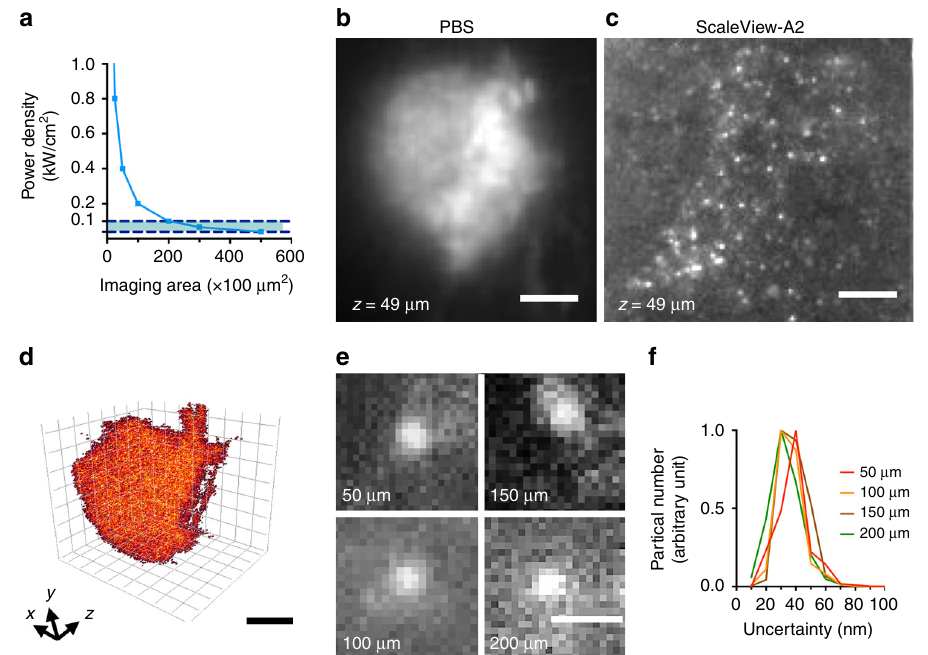
Fig. 2 HMSiR blinking signal at different depths with tissue clearing. a The power density can be achieved by our system is plotted with respect to the imaging area that can be covered by lightsheet. The estimation is made by assuming all the power measuring at the back aperture of the excitation objective (20 mW) is transduced into the lightsheet and the imaging area is product of the axial length and the scanning range of the Bessel beam. The maximum axicon lightsheet coverage is 20,000 μ m 2 (at the power density of 0.1 kW/cm 2 ). Recommended power density ranges for HMSiR activation are indicated in blue. b Representative images of HMSiR blinking signal in phosphate-buffered saline (PBS) and c in Scalview-A2 at the same imaging depth (z = 49 µ m) by imaging the HMSiR-labeled membrane GFP in olfactory projection neurons in MZ19-Gal4 > UAS-mCD8::GFP transgenic fl ies. Images were taken either under a ×25 water dipping objective lens in PBS or a ×25 objective lens speci fi cally designed for use with ScaleView-A2. d Three-dimensional distribution of the signals can be localized in a single volumetric scan. e Representative HMSiR blinking events at four different imaging depths and f overall lateral uncertainty distribution at four different imaging depths in the fl y brain cleared with ScaleView-A2. Scale bar = 20 μ m in ( b – d ), 1 μ m in ( e ). Source data are provided as a Source Data fi